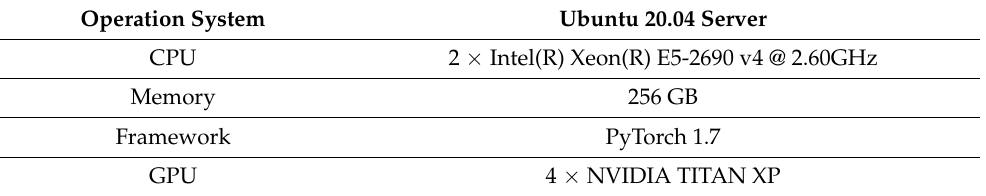
Table 2. Experimental